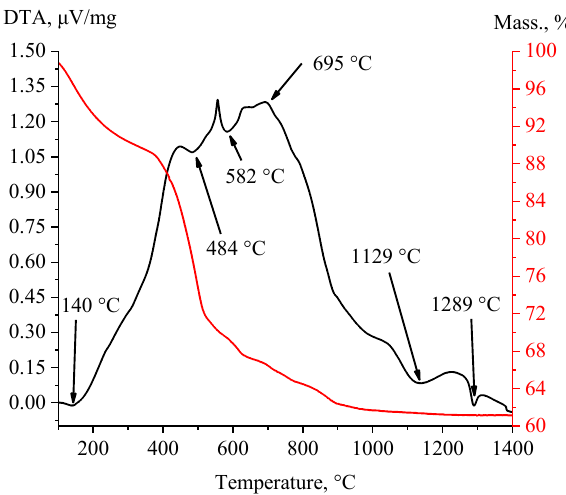
Figure 3. Derivatogram of calcium silicate obtained from calcium acetate.